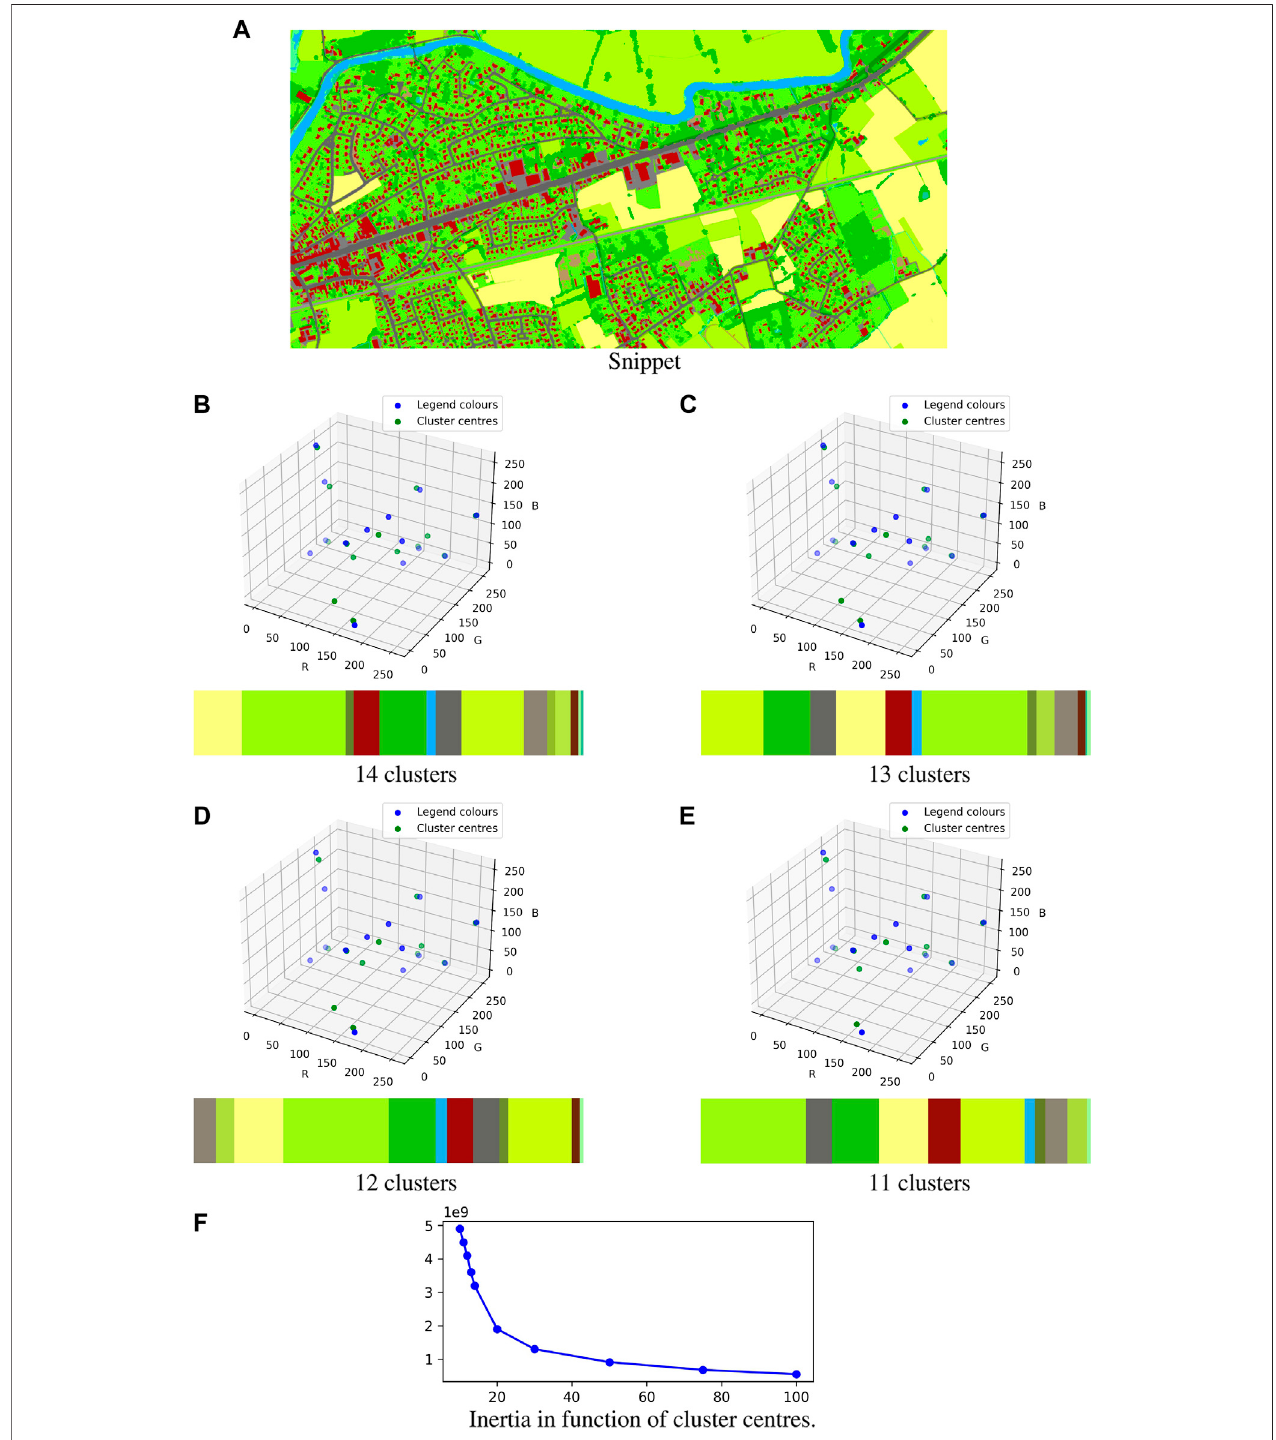
FIGURE 9 | Effect of cluster reduction. (A) Snippet, (B) 14 clusters, (C) 13 clusters, (D) 12 clusters, (E) 11 clusters, (F) inertia in function of cluster centres.